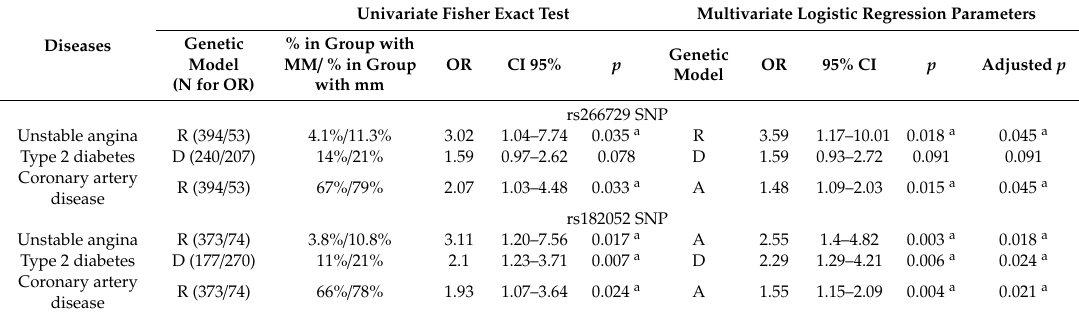
Table 5. Univariate nonparametric test and multivariate logistic regression analysis of associations of the SNPs of the ADIPOQ gene with cardiovascular diseases and diabetes.